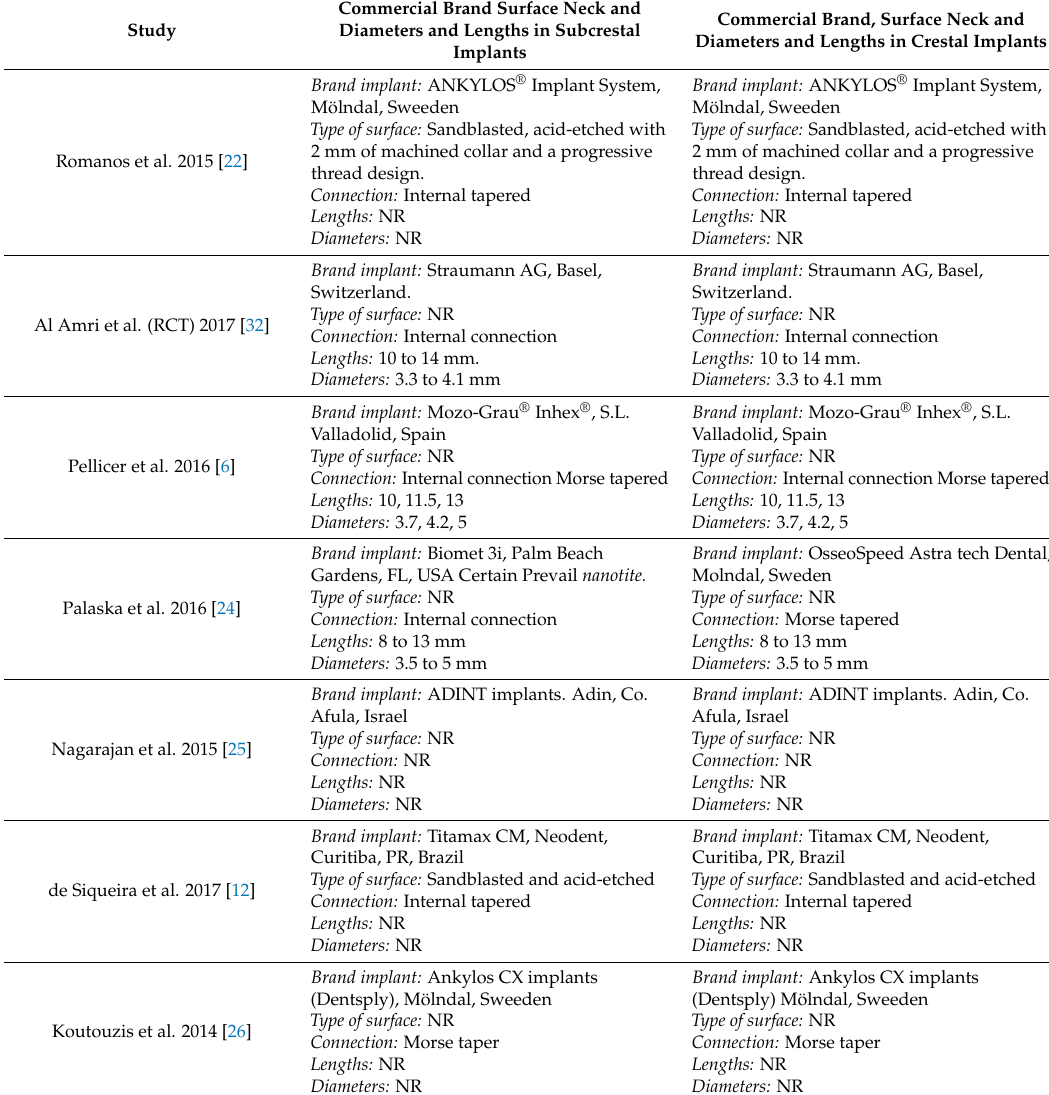
Table 3. Implant characteristics in studies